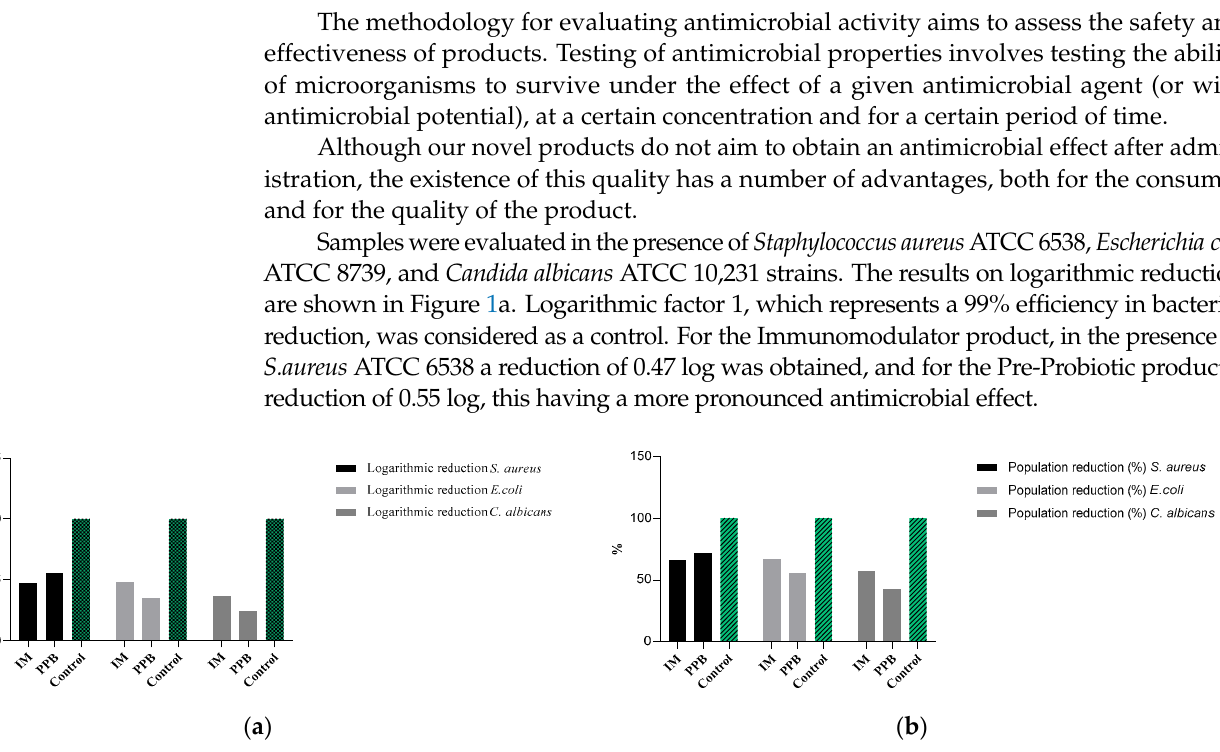
Figure 1. ( a ) Logarithmic reduction and ( b ) Population reduction in Staphylococcus aureus ATCC 6538, Escherichia coli ATCC 8739, and Candida albicans ATCC 10,231 strains by tested samples represented by novel nutraceuticals.